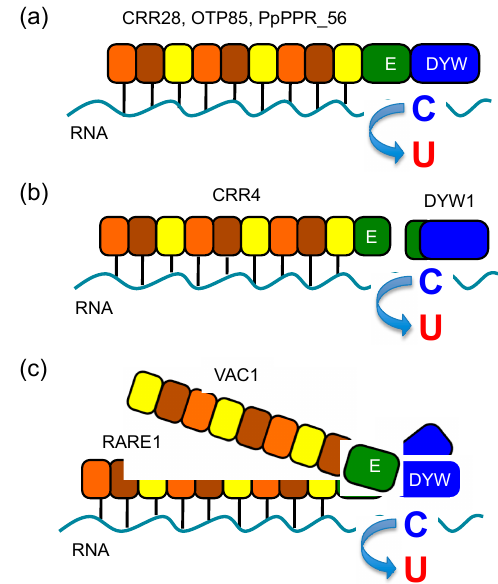
Figure 3. RNA editing requires a single or multiple PPR editing factors. ( a ) Single PPR-DYW editing proteins (e.g., CRR28, OTP85, PpPPR_56) are involved in editing at their target sites; ( b ) PPR-E editing factor (e.g., CRR4) and DYW1 are both required for editing at a single site. PPR proteins recognize the target editing site and DYW1 are involved in trans in editing; ( c ) Two PPR-DYW proteins are cooperatively involved in editing. Either of two PPR-DYW proteins is involved in site recognition and another one may be required for the C-to-U editing reaction.